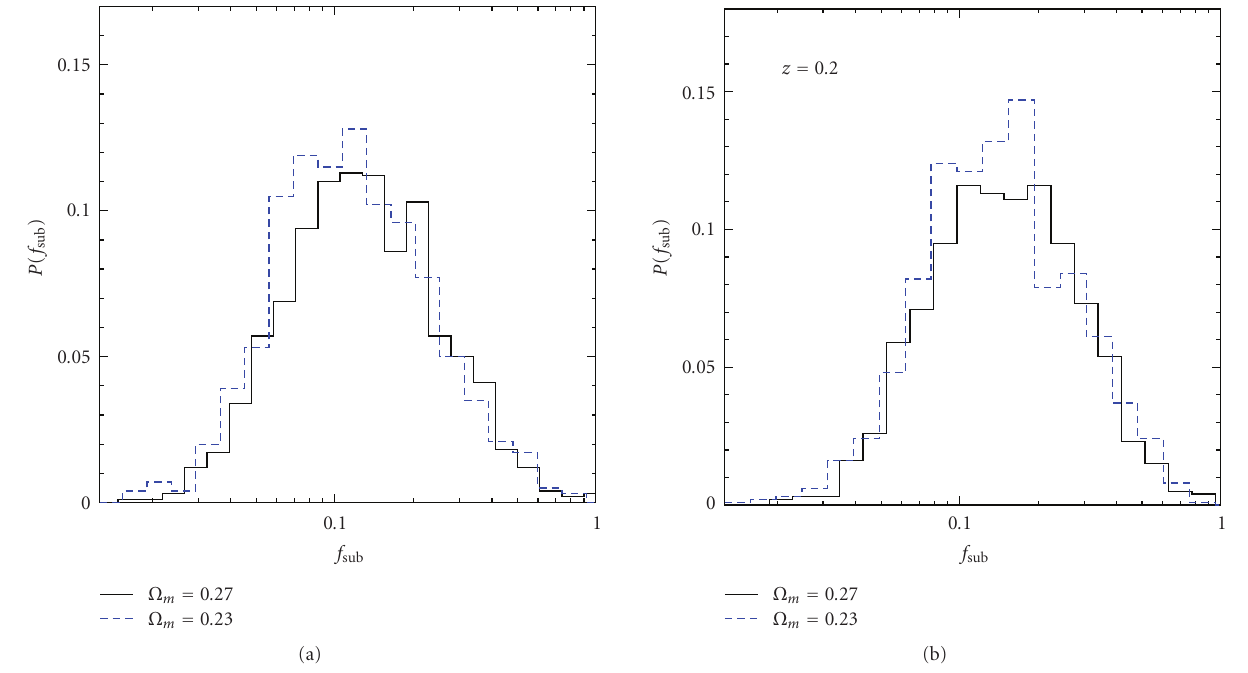
Figure 7: Distributions of lensing substructure fraction at z = 0 (a) and z = 0 . 2 (b). The solid histogram is for 1000 merger trees in a cosmology with Ω m = 0 . 27, σ 8 = 0 . 80. The dashed histogram is for 1000 merger trees in a cosmology with Ω m = 0 . 23, σ 8 = 0 . 85. These two cosmologies are chosen to produce the same abundance of massive clusters at low redshift, so cluster number counts alone would not distinguish between